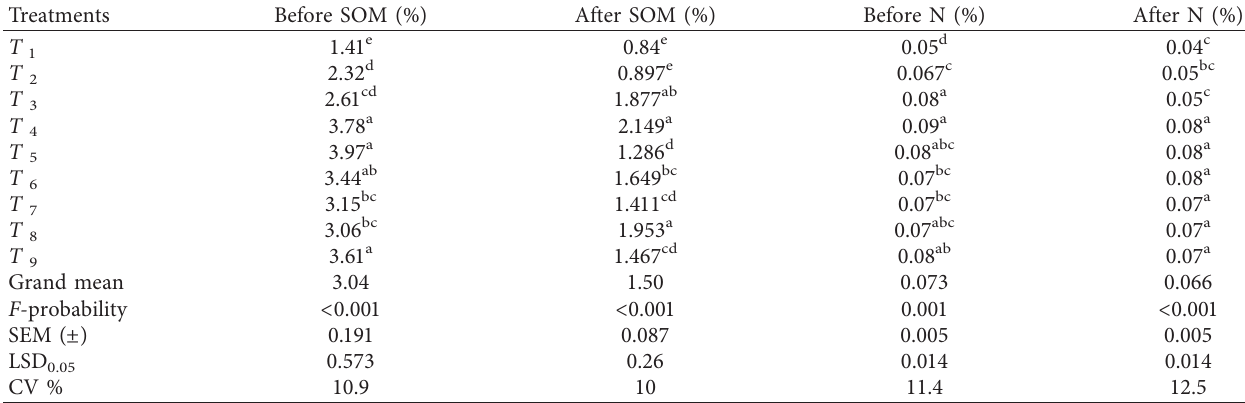
Table 7: Soil nitrogen and organic matter content before and after wheat harvest. Treatments Before SOM